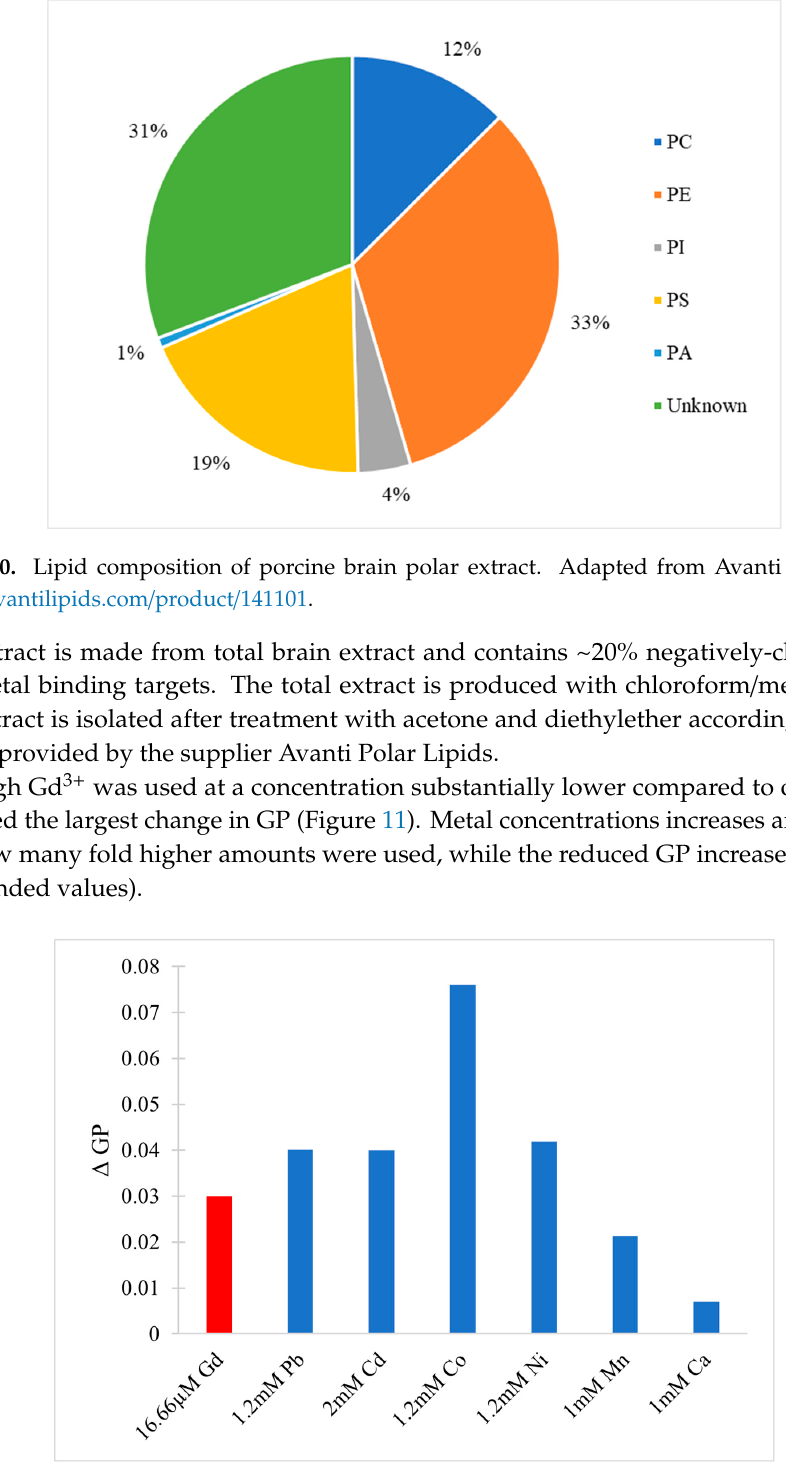
Figure 9. Generalized polarization of brain SM liposomes in the presence of various heavy metals.